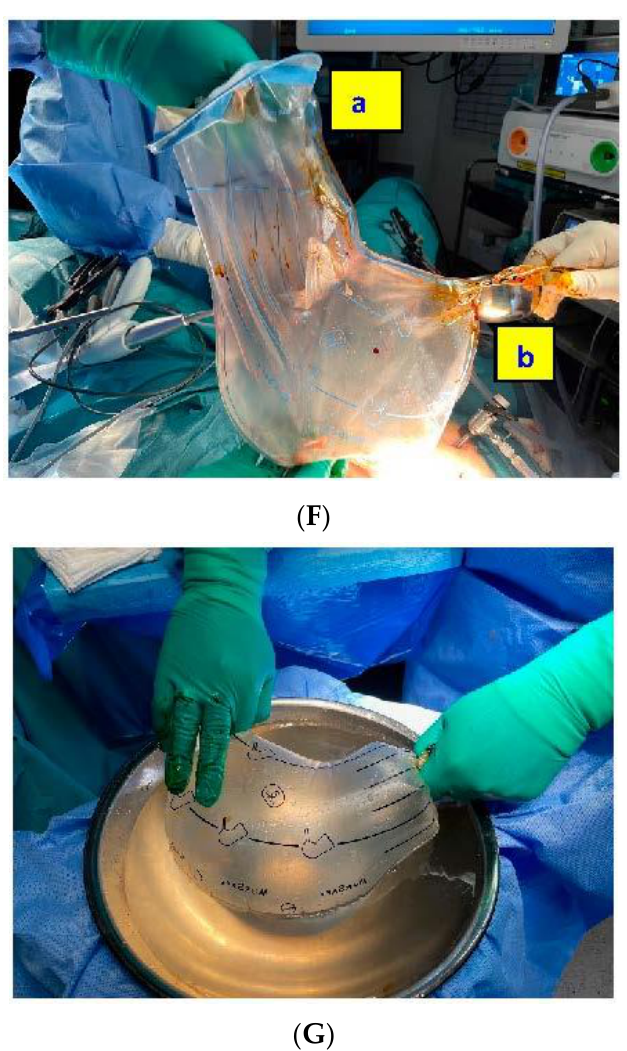
Figure 3. Main steps of the in-bag morcellation process (MorSafe ® system). ( A ) Typical port config- uration to access a giant uterus consisting of (a) Telescopic port, (b) ports for surgical instruments, and (c) larger port for instruments and morcellator. ( B ) Bag insertion through the larger port (a) under visual guidance from telescopic port (b). ( C ) Morcellator (a) and telescope (b) are placed within the respective sleeves. ( D ) The morcellator is manipulated through the morcellation sleeve (a) and the camera is inserted through the telescopic sleeve (b), allowing a visual control of the mor- cellation process. The bag is insufflated with CO 2 . ( E ). Bag is drawn-out through the morcellator port (a) after deflation and tying of the telescopic sleeve (b) to prevent spillage. ( F ) The bag is inspected for any obvious disruption. (a) Morcellator and specimen sleeve opening, (b) Tied telescopic sleeve. ( G ) Finally, submersible puncture test is performed on the bag.